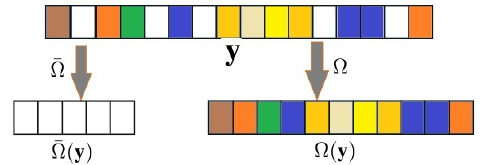
Figure 2. Extracting known and bleed-through pixels in a